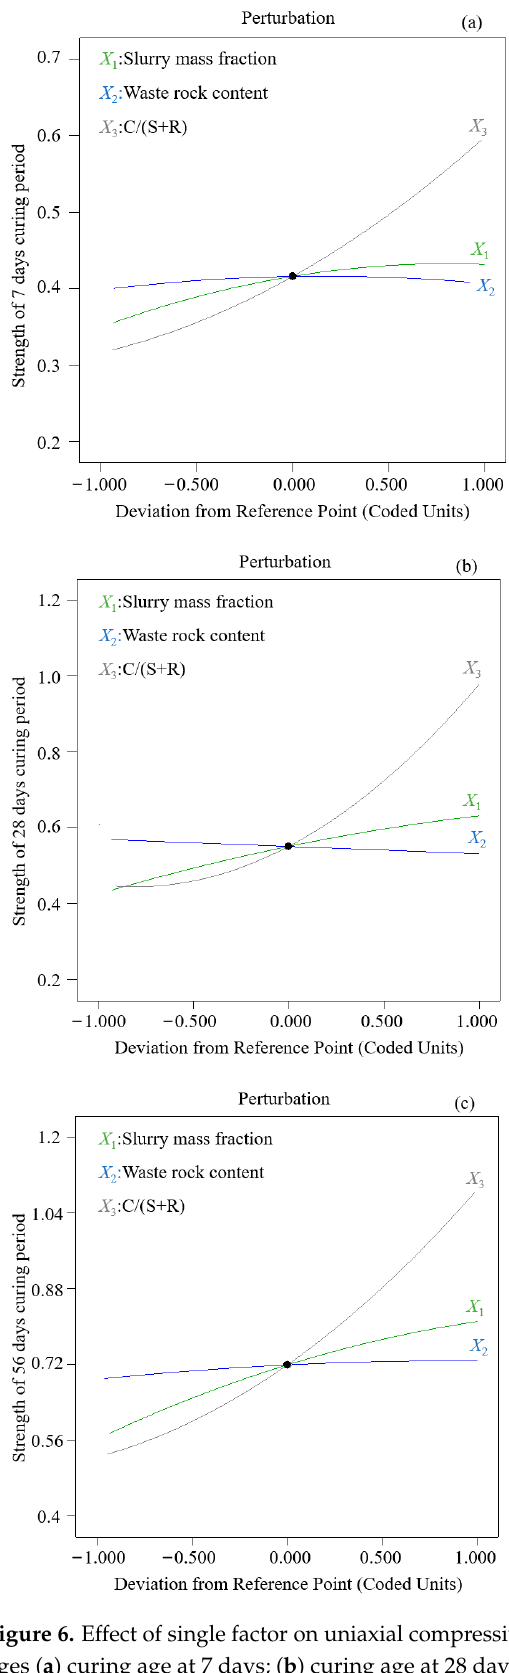
Figure 6. Effect of single factor on uniaxial compressive strength (UCS) of backfill at different curing ages ( a ) curing age at 7 days; ( b ) curing age at 28 days; ( c ) curing age at 56